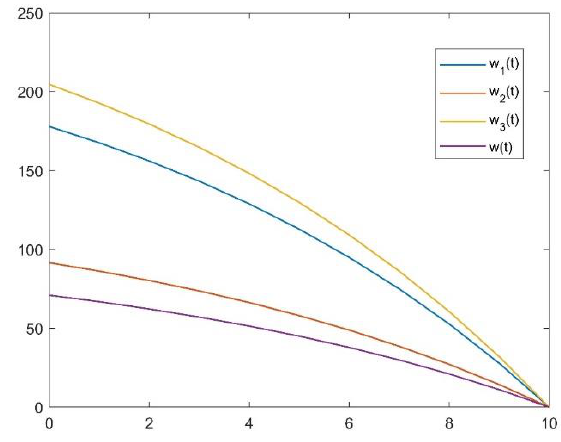
Figure 3. The differentiated and single-channel advertising efforts rate.